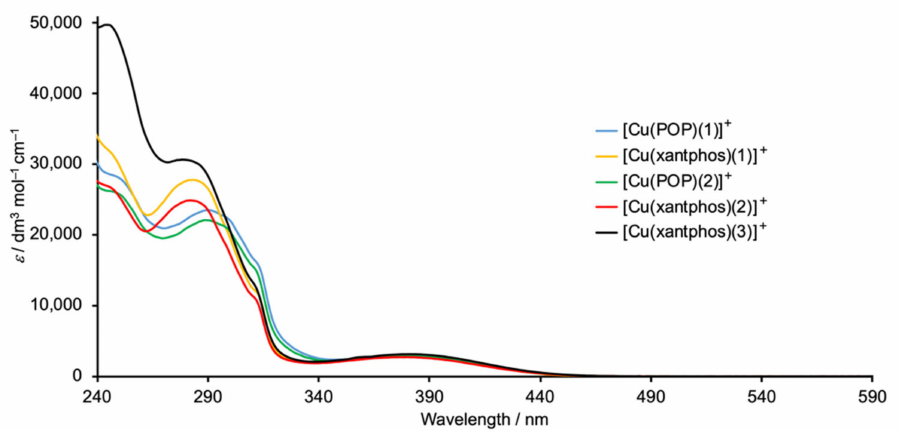
Figure 9. Solution absorption spectra (CH 2 Cl 2 , 2.5 × 10 − 5 mol dm − 3 ) of the heteroleptic copper(I)